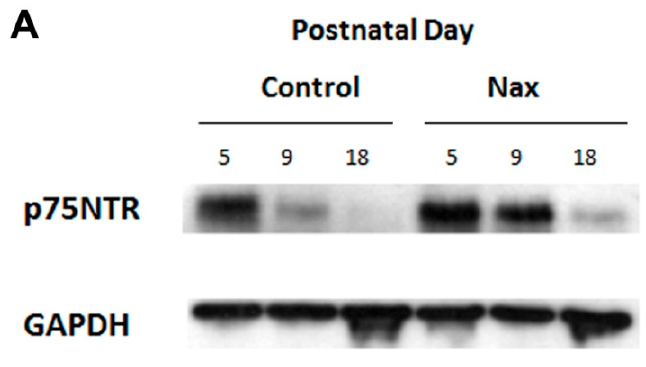
Figure 5. Cont . Figure 5.